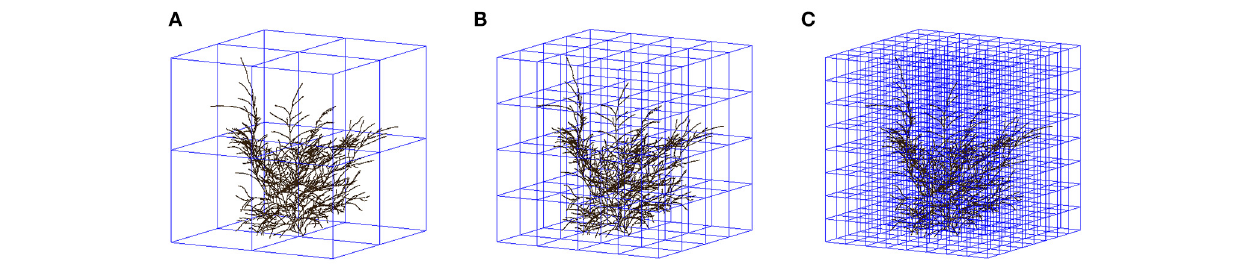
FIGURE 2 | Illustration of three successive steps in the cube-counting procedure of fractal dimension estimation, i.e., the steps in which one of the smallest cubes to contain the entire skeletal branching pattern of a miniature coniferous tree (here, Microbiota decussata Gold Spot) is divided into (A) 8 = 2 × 2 × 2; (B) 64 = 4 × 4 × 4; and (C) 512 = 8 × 8 × 8 cubes which have a sidelength equal to (A) 1/2; (B)